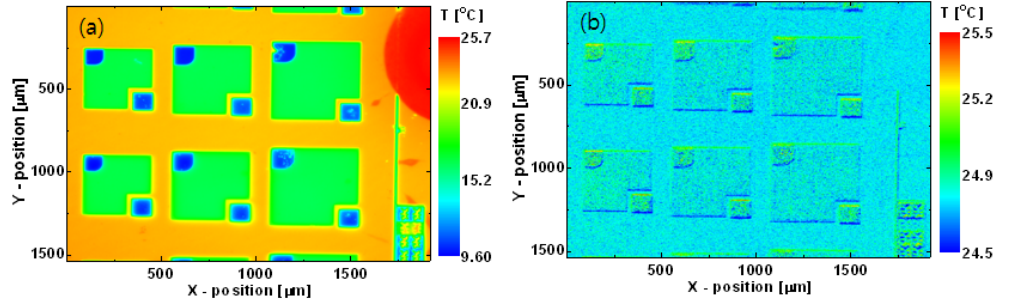
Figure 7. ( a ) Uncorrected and ( b ) corrected temperature images of unbiased LED wafer at a uniform heat sink temperature of 25 ° C.